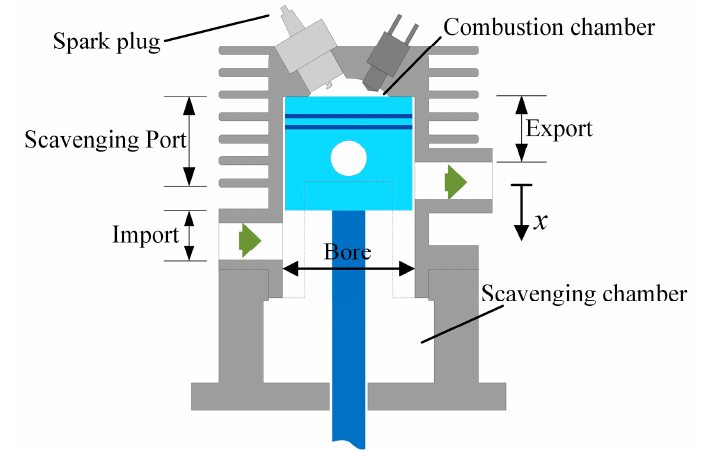
Figure 3. Structure of the combustion system Table 1. Combustion system of the FPEG.